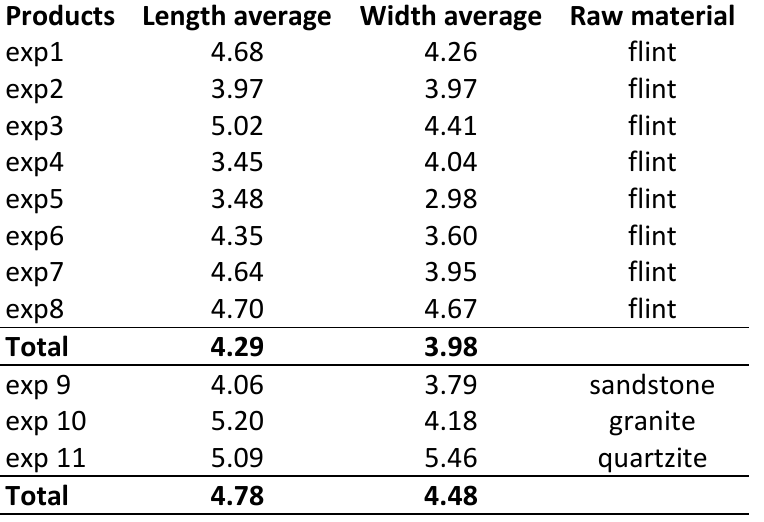
Table 2. Average sizes of flakes made with flint-hammerstones.